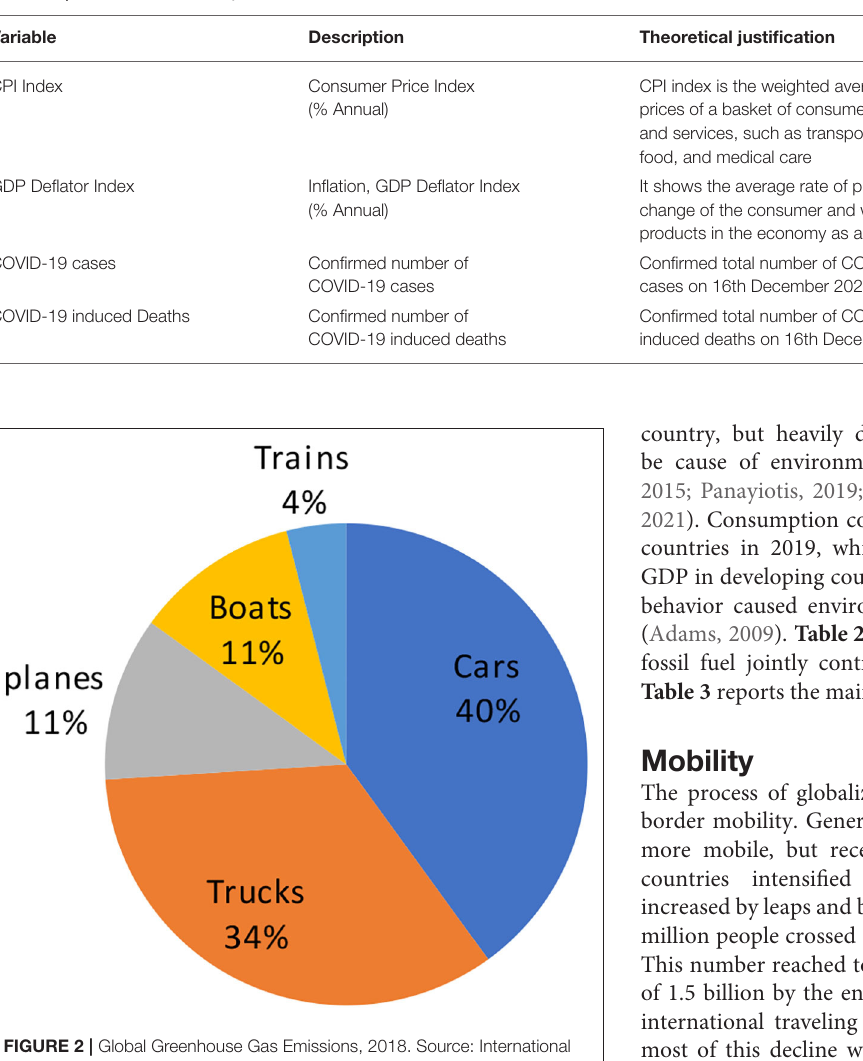
TABLE 3 | Variables, theoretical justifications, and data sources.